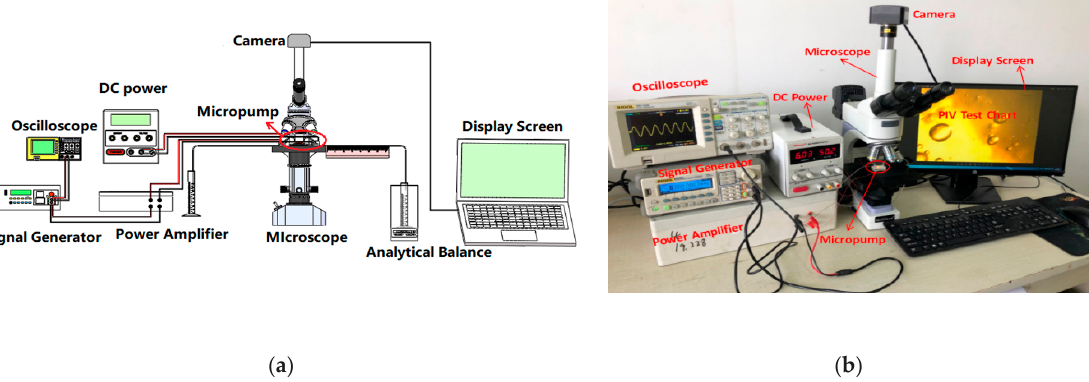
Figure 4. Layout of the experiment setup and control system. ( a ) Schematic of the flow rate and flow field of the micropump with different driving methods. ( b ) Photograph of the performance testing system of the whole micropump with LC/PZT driving methods.